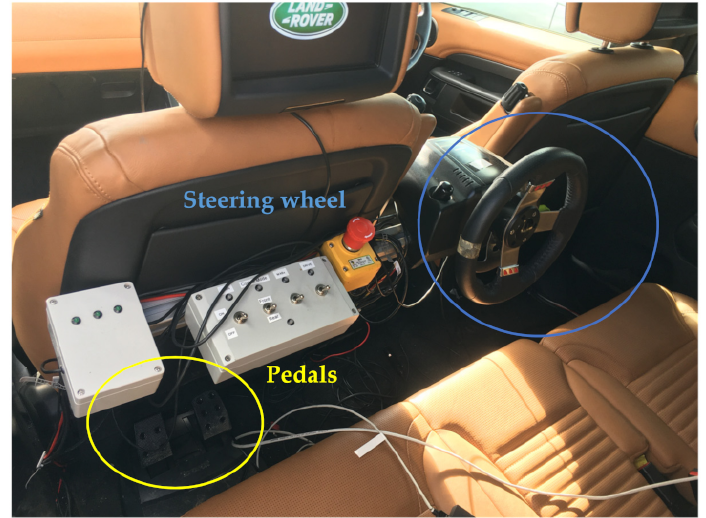
Figure 6. A view of the modified vehicle, where the rear steering wheel and pedal have been